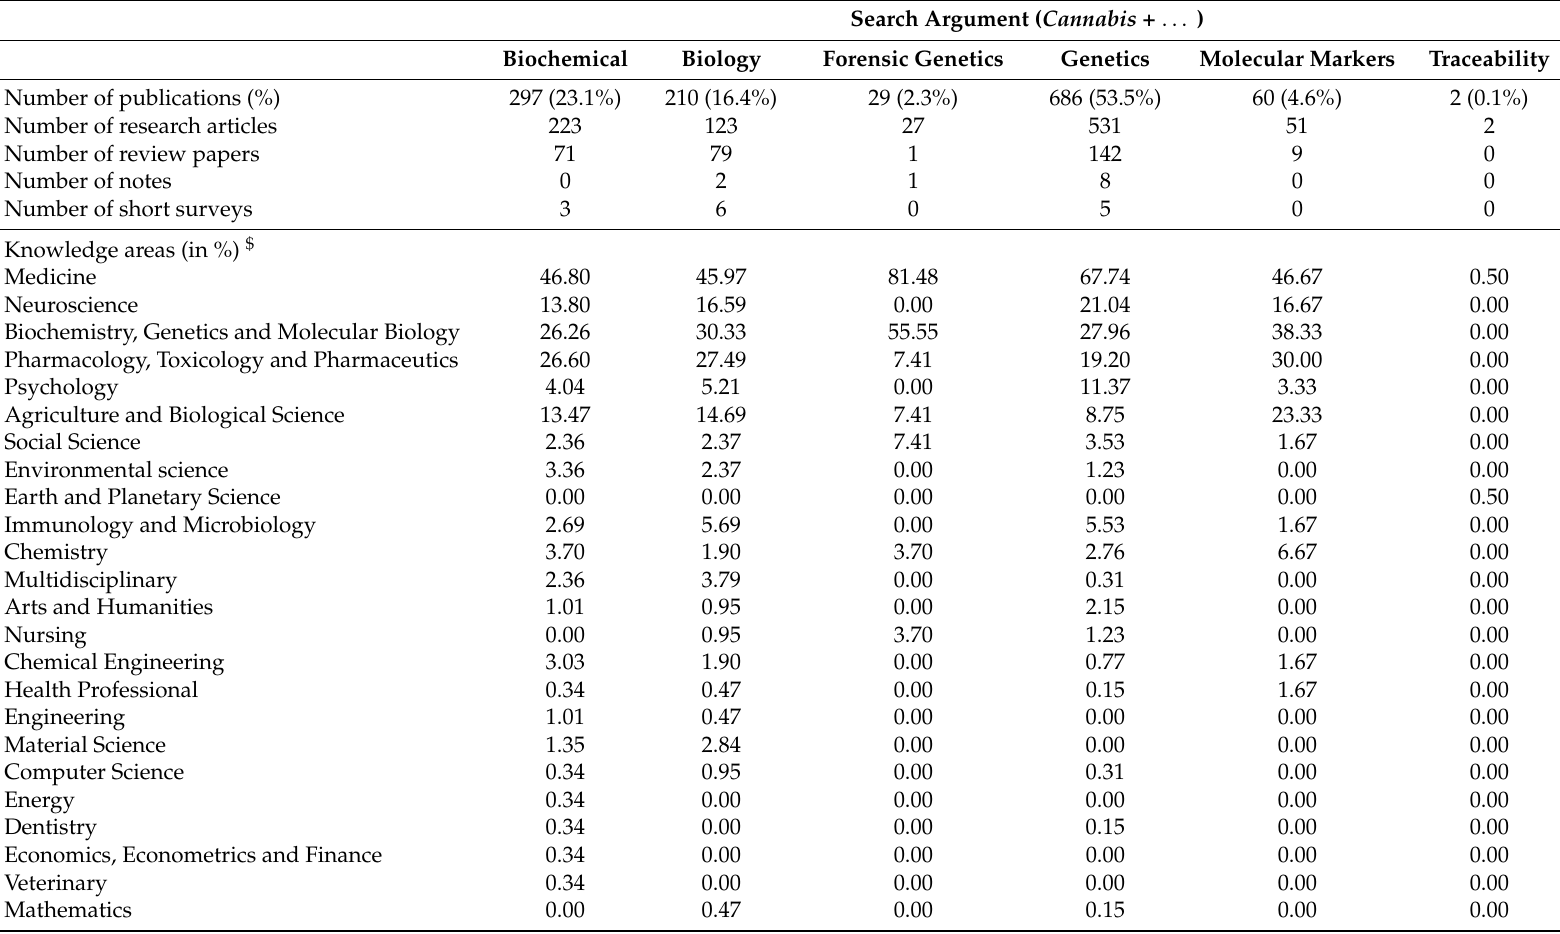
Table 1. Number of scientific publications recorded from the Scopus platform for each search argument ( Cannabis + . . . ) over the whole timespan in each knowledge area and in each